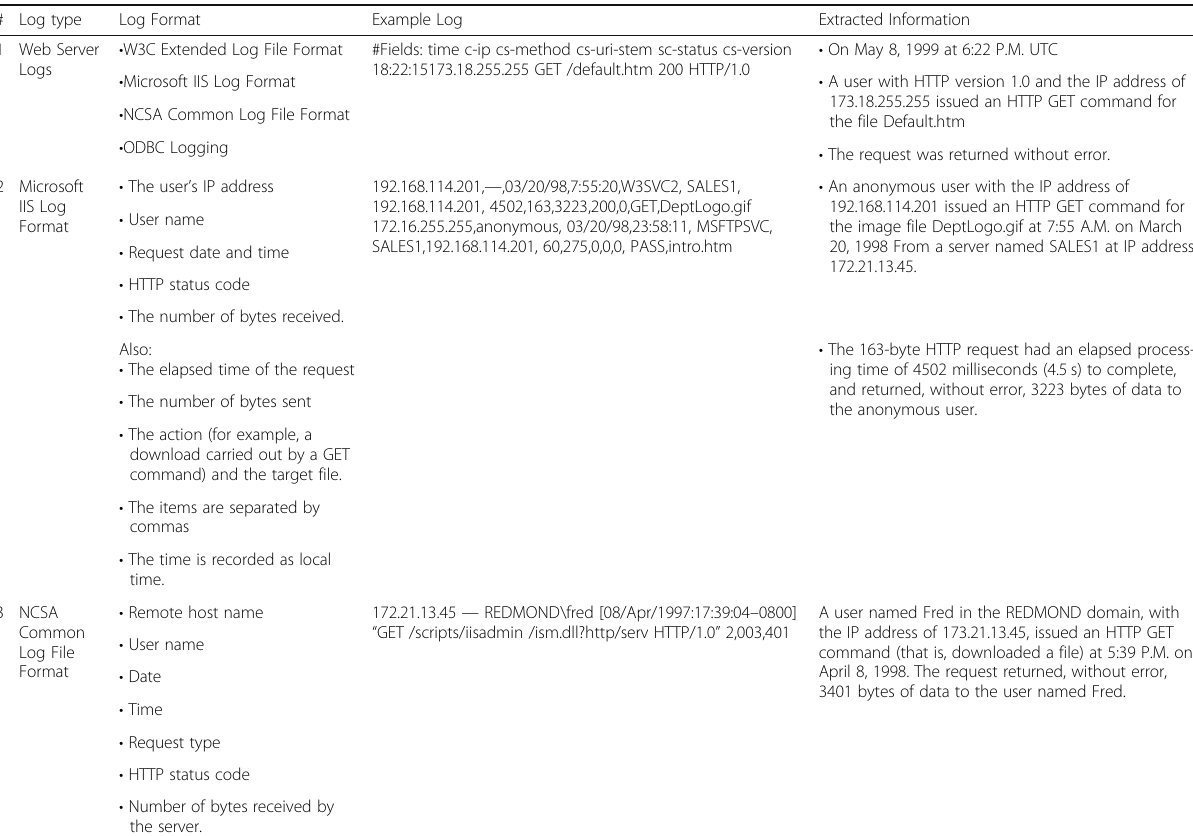
Table 1 Web data